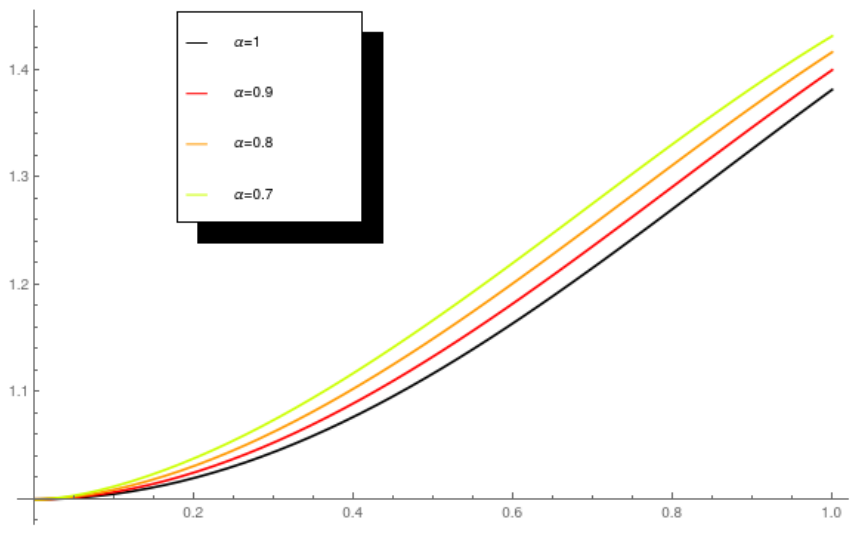
Figure 3. Approximate solutions of (19) for several values of α